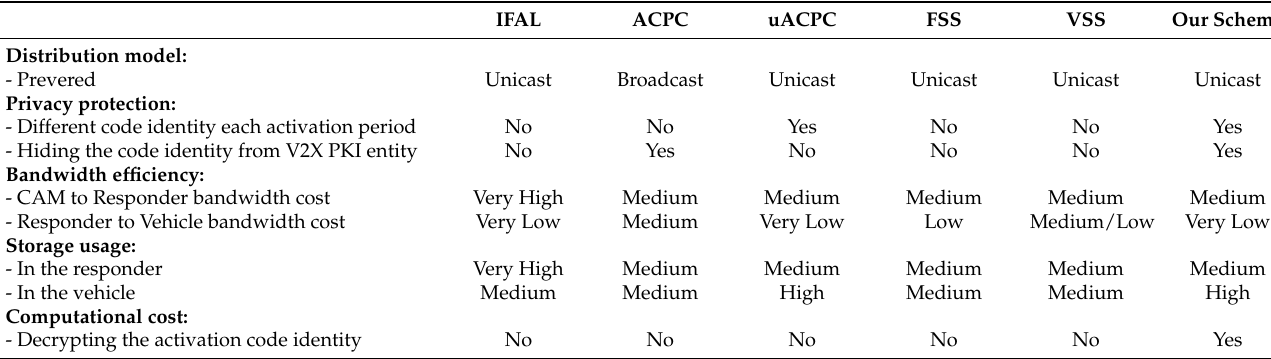
Table 3. Comparison of activation-code-based schemes.